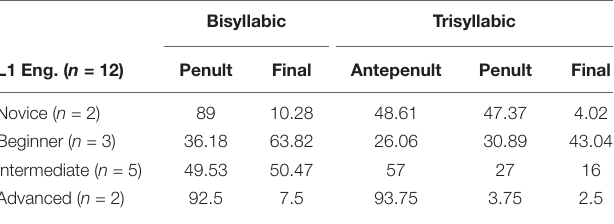
TABLE 4 | General results on stimuli with all light syllables: percentage